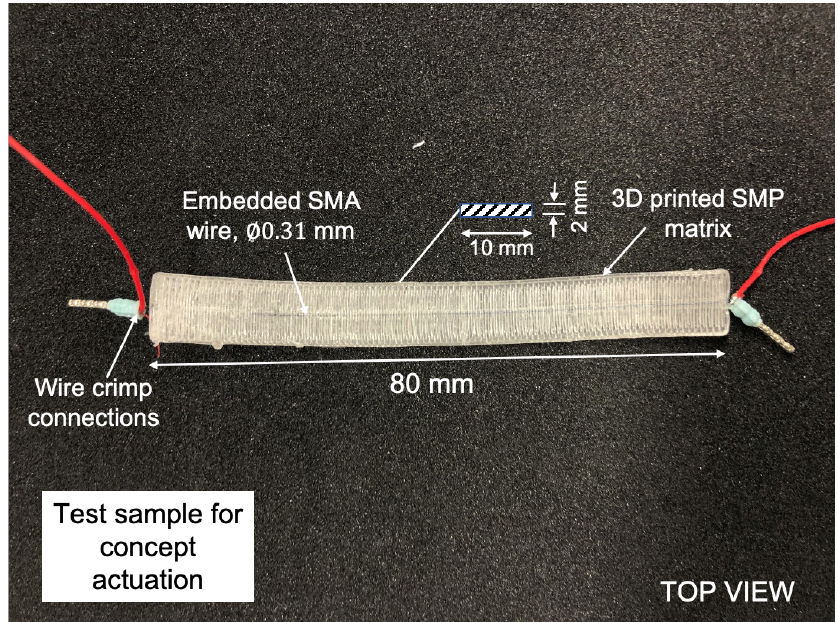
Figure 6. The fabricated SMC with the SMA wire shape set to a 35 mm radius of curvature and prestrained inside the SMP